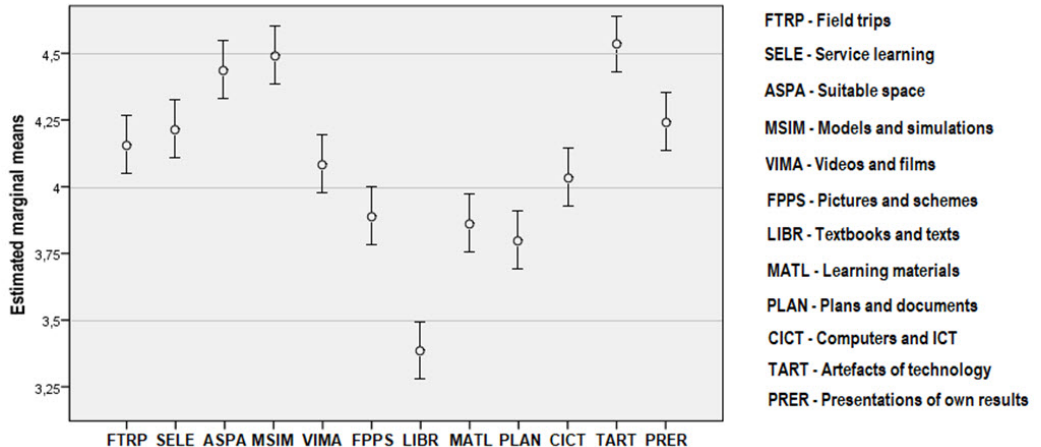
Figure 1. Estimates of the influence of contextual elements on pupils’